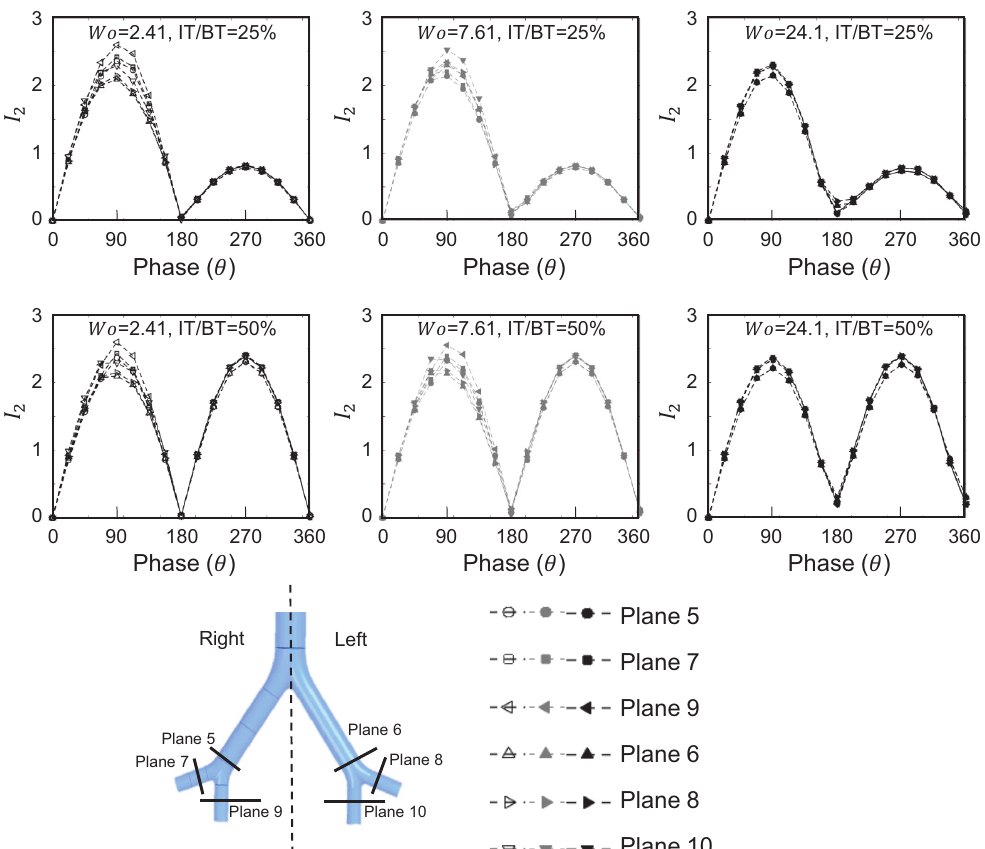
Figure 15. Integral parameter I 2 calculated at Planes 5–10 for all breathing conditions at IT/BT = 25% ( top row ) and IT/BT = 50% ( bottom row ). Refer to Figure 13 for marker